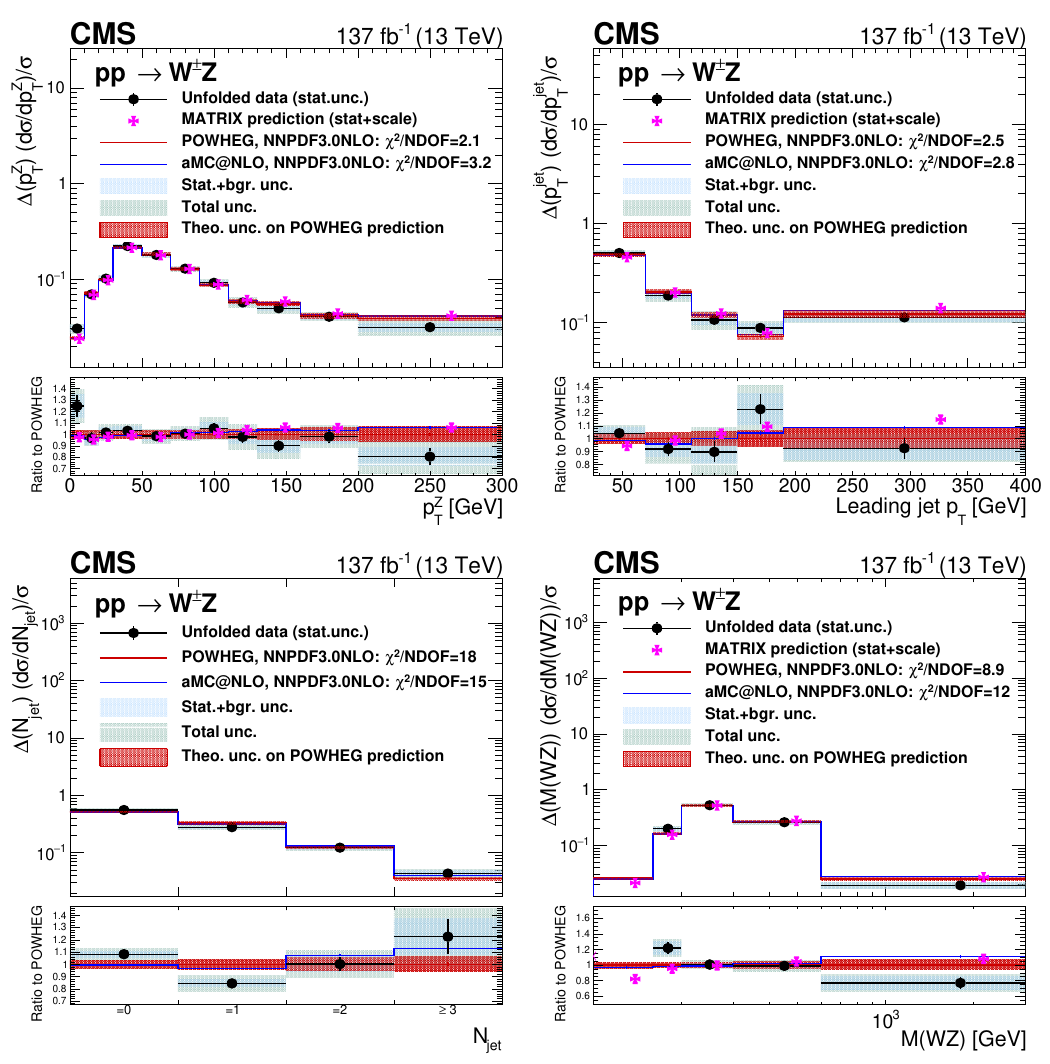
value of the Z boson (top left), the Figure 14 . Unfolded results for several variables: the p T value of the leading jet in the event (top right), the jet multiplicity (bottom left) and the p T M (WZ) variable (bottom right). Black dots represent unfolded data results, black vertical bars denote statistical uncertainties in the unfolded data results, shaded blue bands represent statistical plus background-related uncertainties, and the green band shows the total unfolding uncertainty. The red histogram and shadow bands are the powheg prediction and its theoretical uncertainty. The blue histogram represents the MadGraph 5_a mc@nlo prediction and the violet points show the matrix prediction including error bands representing numerical and scale uncertainties. The matrix predictions are represented by points with a small offset to the right to improve readability. The matrix predictions for the jet multiplicity differential cross section are not included as they correspond to a fixed order computation not matched to a parton